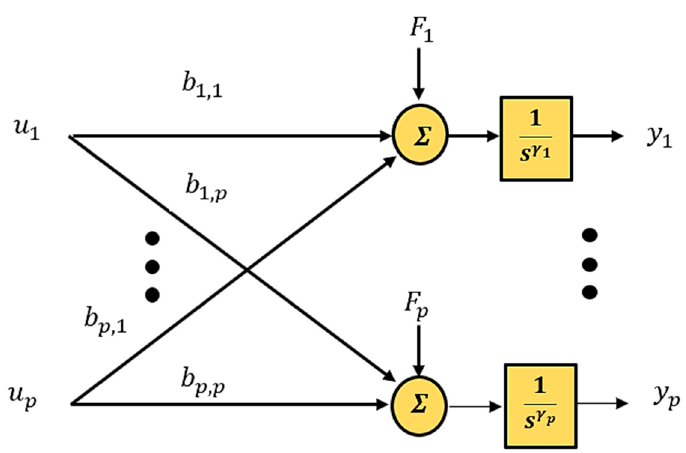
Figure 2. Generalized disturbance representation for the MIMO nonlinear system.